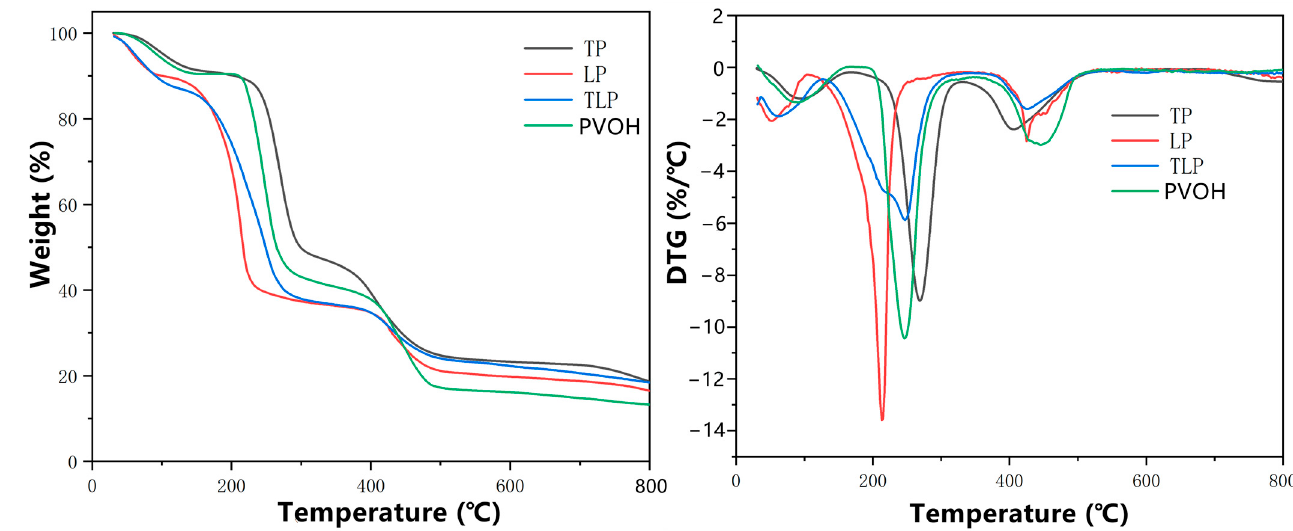
Figure 5. TGA and DTG profiles of the different films.